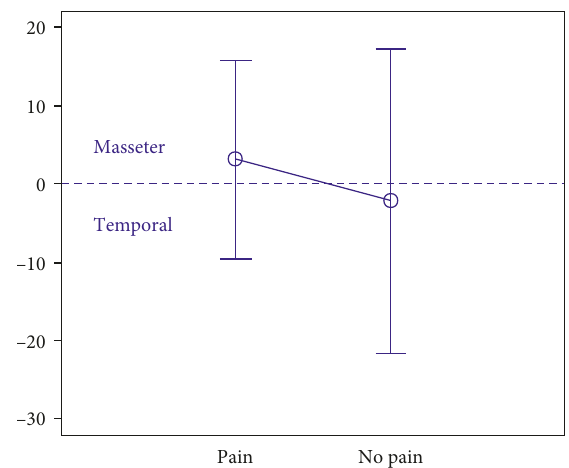
Figure 2: Activity index at rest in group of TMD individuals.